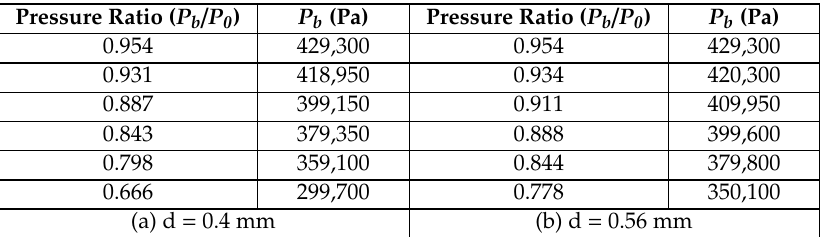
Table 1. Pressure ratio of outlet pressure ( P b ) to inlet pressure ( P 0 ).